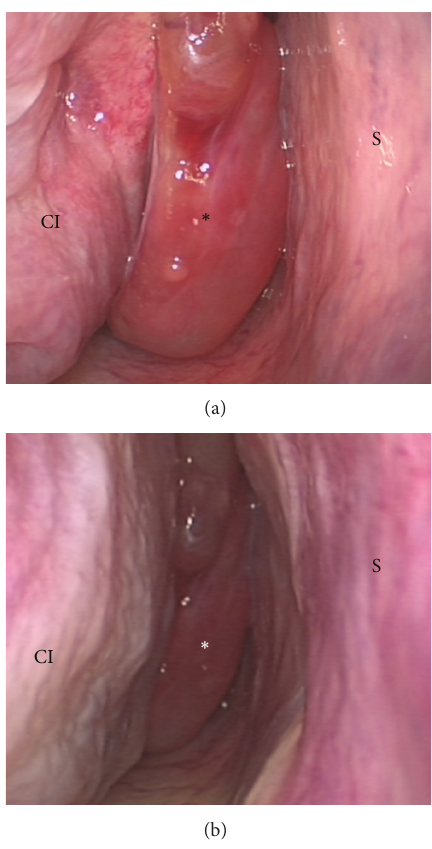
Figure 1: Endoscopic view of the operational field before surgery (a). After embolization, shrinking is clearly seen (b). Nasal septum (S), concha inferior (CI), concha media (CM), sphenoid sinus (SS), and tumor ( ∗